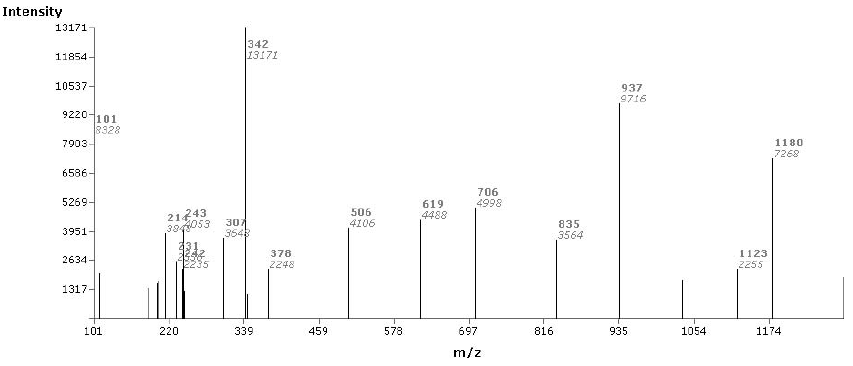
Figure 3. Example of a PFF spectrum from the HUPO Brain Proteome Project The bold numbers associated with each peak give the m/z value, while the italic numbers associated with the peak show the intensity value. This ‘‘ stick ’’ spectrum has been processed from the raw output of the mass spectrometer. Available at http://www.ebi.ac.uk/pride/viewSpectrum. do?mzDataAccession ¼ 1717&spectrumReference ¼